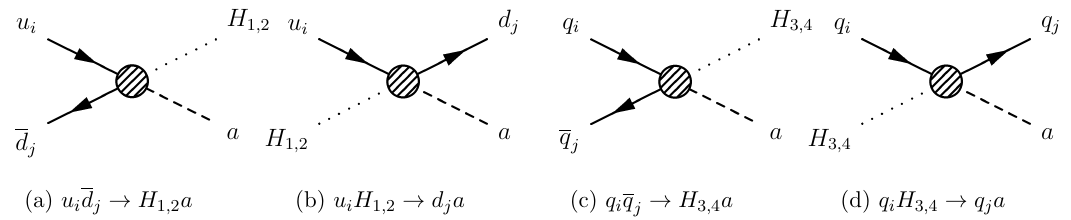
Figure 1: The four processes which dominate the production rate of a Goldstone Boson a from its couplings to SM quarks. Here, the indices i and j represent flavor indices, and q = u, d can denote an up-like or down-like quark. H T = ( H 1 + iH 2 , H 3 + iH 4 ) / √ 2 denotes the SM Higgs field before electroweak symmetry breaking.